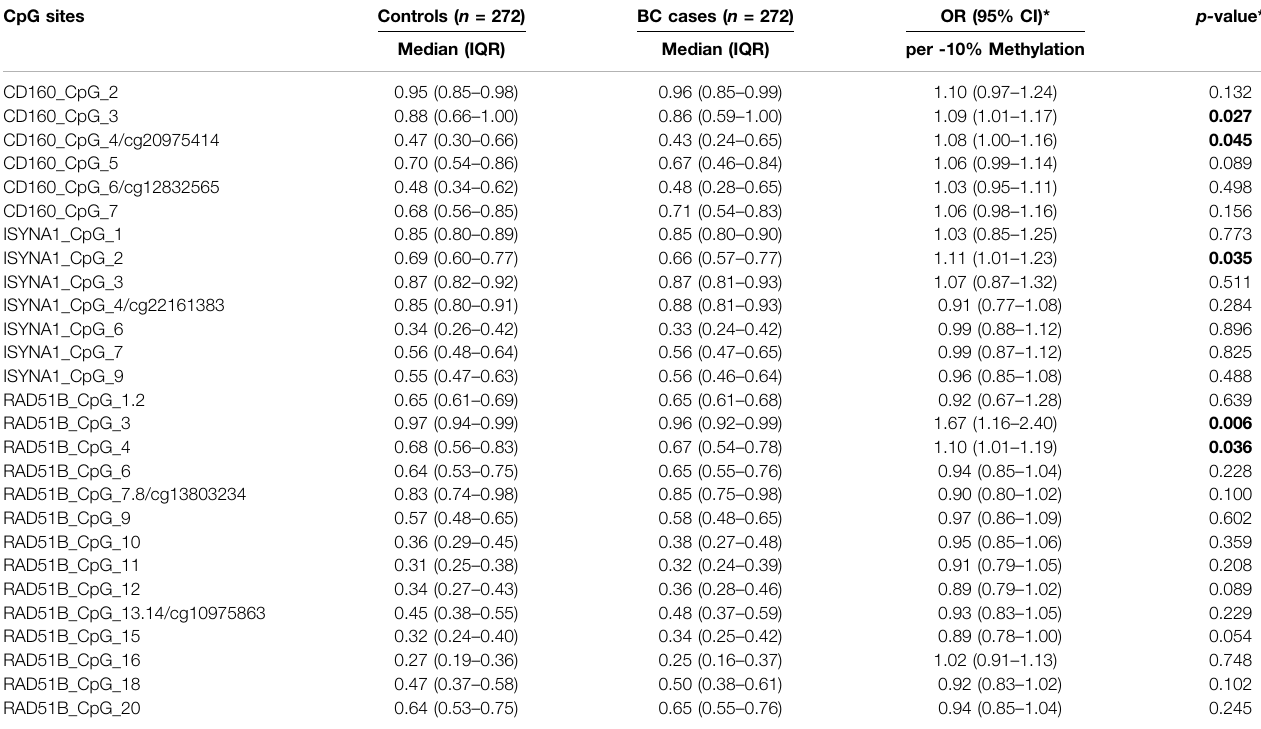
TABLE 1 | Association between hypomethylation of CD160 , ISYNA1 , and RAD51B and sporadic BC combining validation I and validation II. CpG sites Controls ( n =